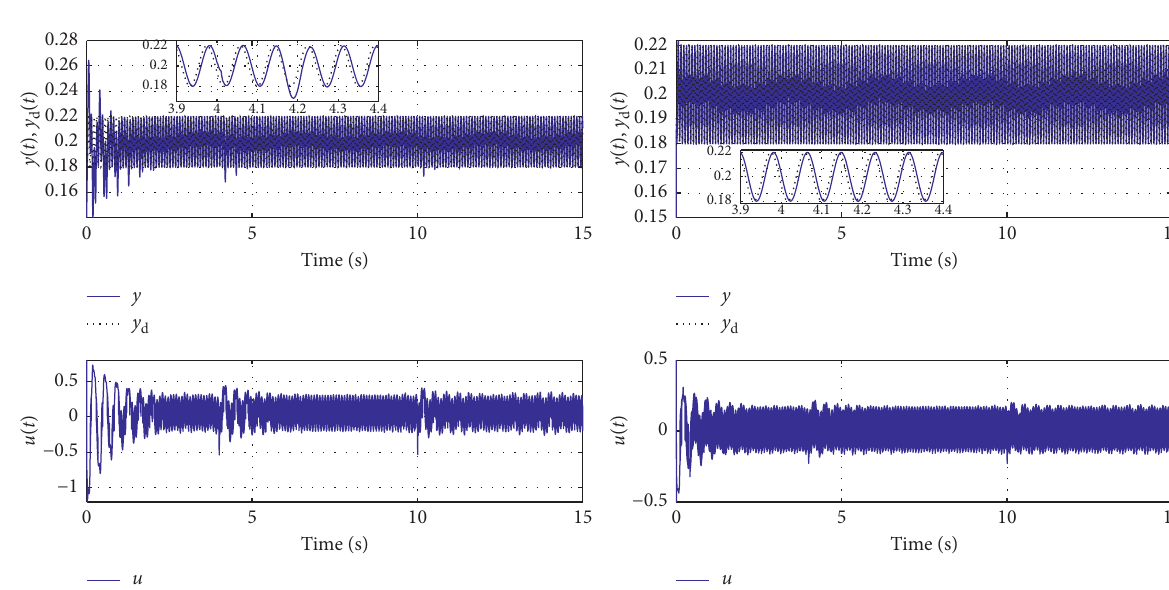
Figure 16: Control performance of NN-FOSM and NN-FFOSM in case